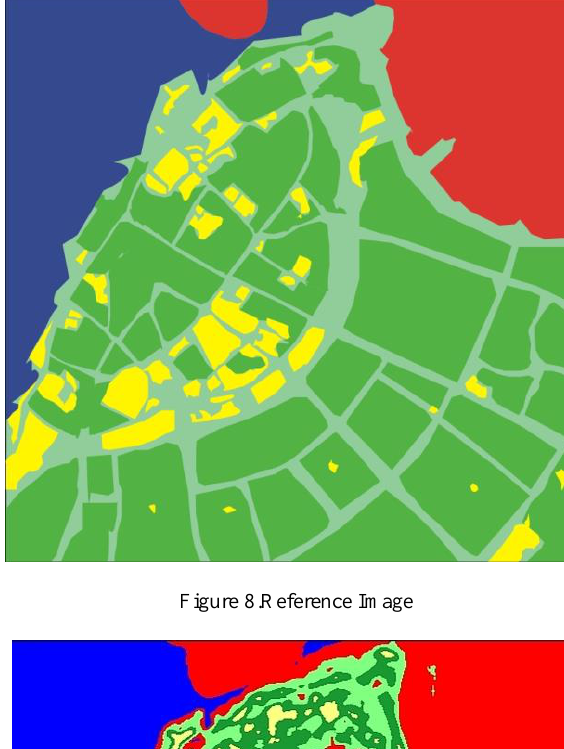
Figure 8.Reference Image